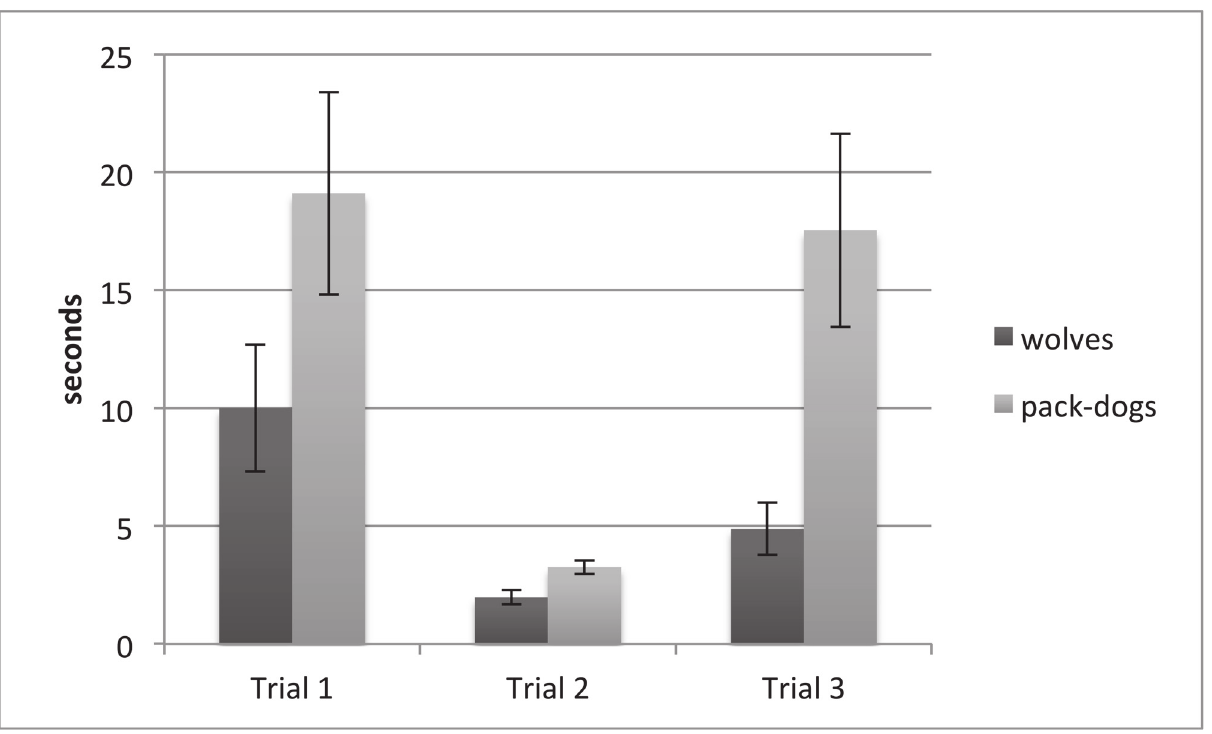
Fig 1. Wolves ’ and pack-dogs ’ performance in the detour task. Mean duration (in seconds) and SE of time spent close to the fence in front of the food by wolves and dogs in the detour task. * p < 0.01.